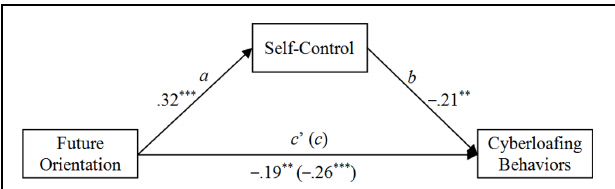
FIGURE 1 | Mediation of future orientation and cyberloafing behaviors by self-control. Total effect ( c ): Effect = –0.26, SE = 0.07, p <